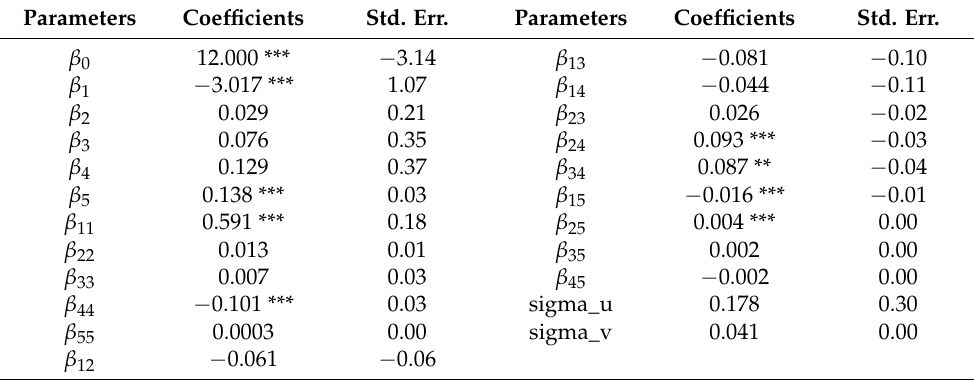
Table 2. The estimation results of trans-log production function.